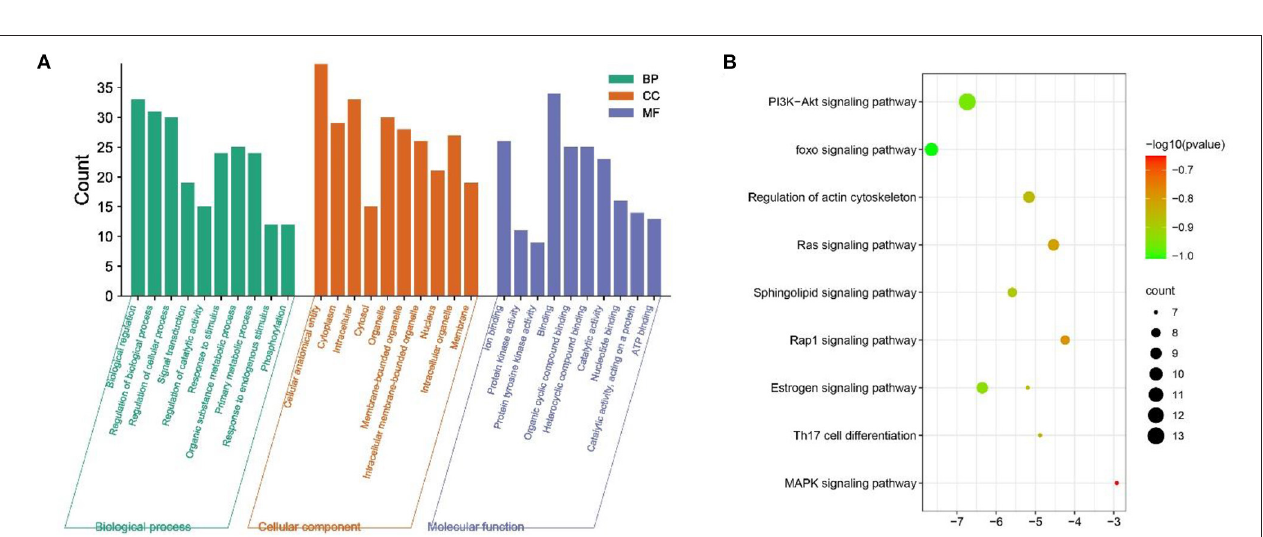
FIGURE 4 | Protein-protein interaction enrichment analysis. (A) Protein-protein interaction networks identified in the gene list. Circles represent target proteins, the same color is an MCODE, forming a subset of interacting proteins. (B) Identified in the list of genes MCODE components.